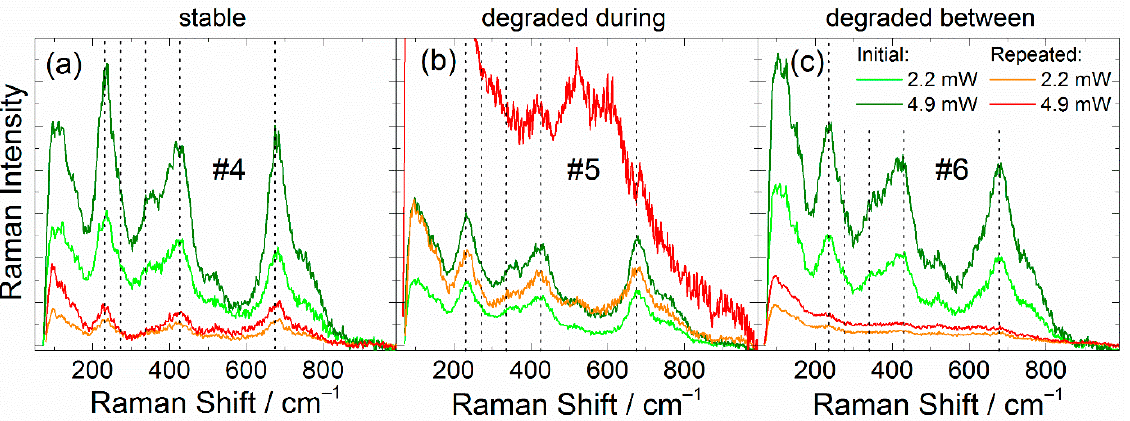
Figure 2. Raman spectra measured at two-month intervals for ( a ) “stable” particle #4, and ( b ) particle #5, degraded during repeated measurement, and ( c ) particle #6, degraded between initial and repeated measurements.